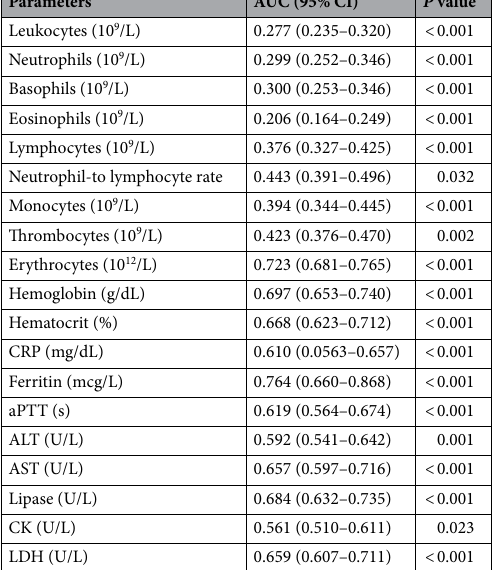
Table 2. Diagnostic performance of each continuous blood laboratory parameters to distinguish between COVID-19 positive from negative tested patients. Abbreviations: ALT alanine aminotransferase, aPTT activated partial thromboplastin time, AST aspartate aminotransferase, AUC area under the curve, CK creatine kinase, CRP C-reactive protein, LDH lactate dehydrogenase, NLR neutrophil-to-lymphocyte ratio.